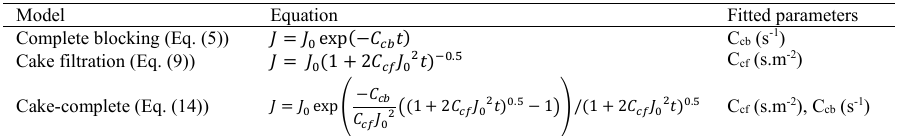
C cb (s -1 ) C cf (s.m -2 )